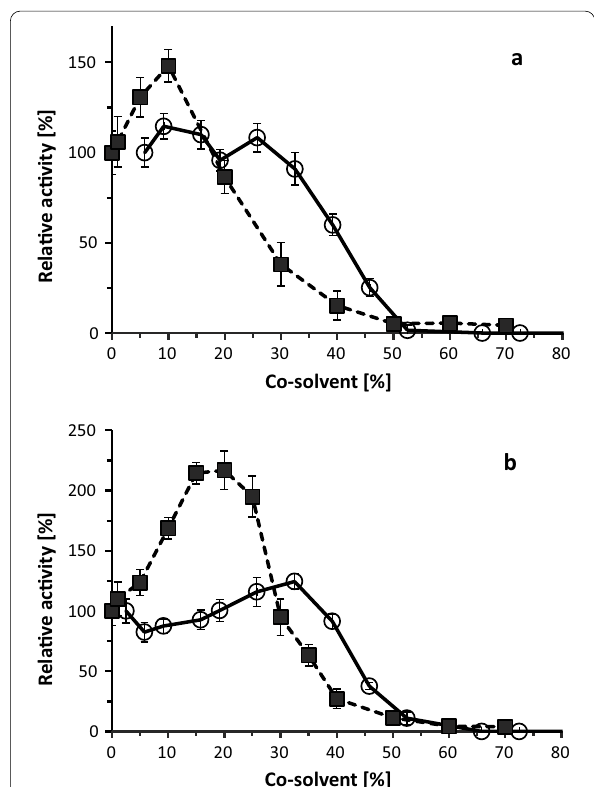
Fig. 3 Influence of ethanol and DMSO on the initial hydrolysis rate of 2 . a Mc Glc in 50 mM citrate buffer (pH 3.5) at 48 °C; b Pc Glc in 50 mM citrate buffer (pH 5.0) at 48 °C. The measurements were performed in triplicate in the presence of different co-solvent concentrations (%, v/v): 2 mM of 2 with varying concentrations of ethanol ( ■ ); DMSO (